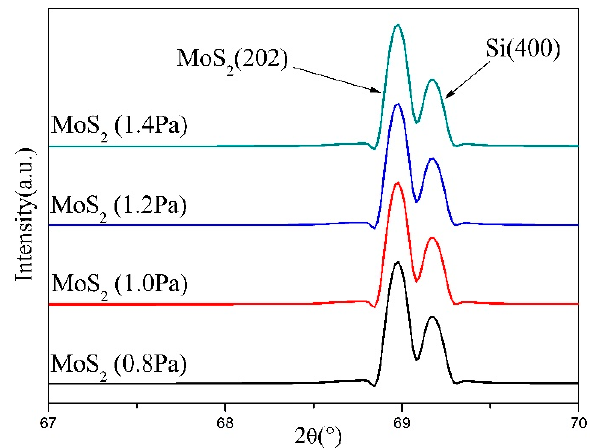
Figure 1. XRD patterns of the MoS 2 films deposited at different pressures.